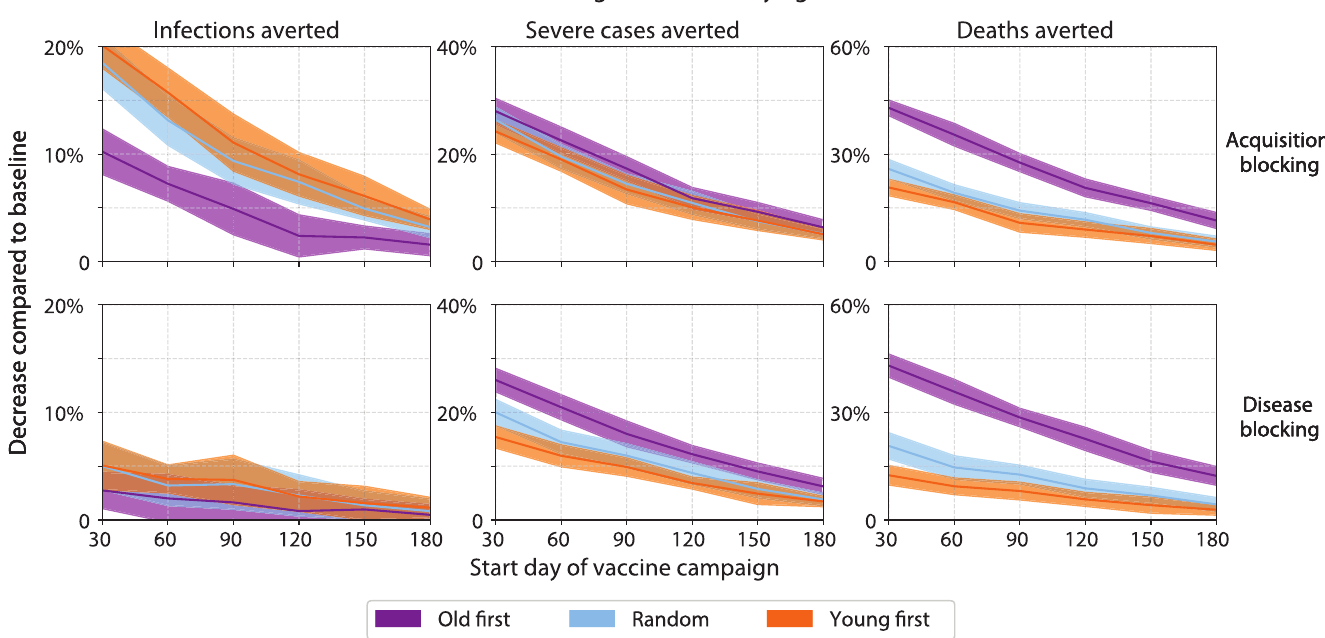
Fig 8. Vaccination impact by age prioritization and timing of vaccine introduction. Age groups for prioritization were as follows: “old first” = beginning with adults age 70 years or older; “young first” = beginning with adults age 15–49 years; “random” = without prioritization (i.e., all ages have equal priority).